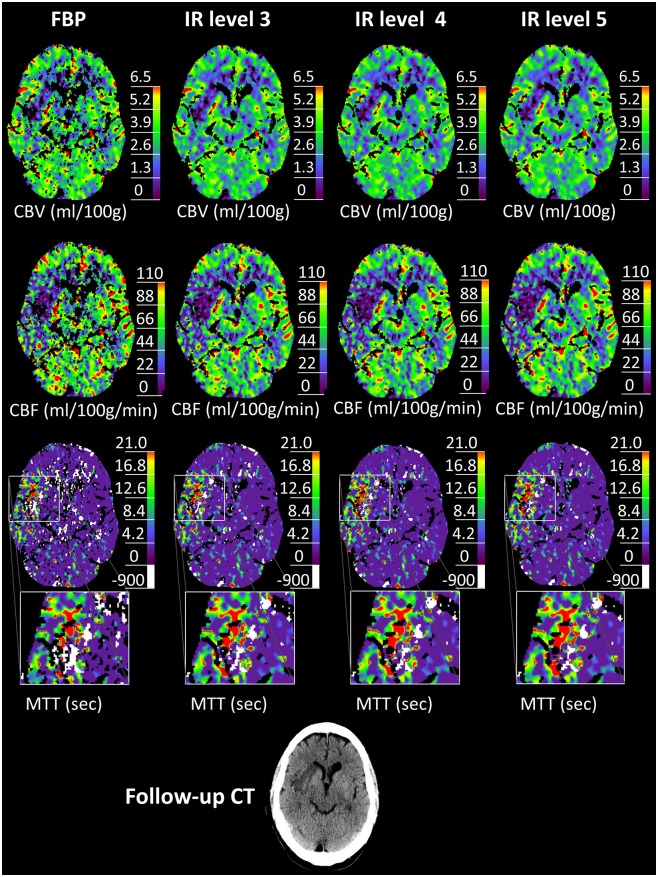
Example CTP images 1.Note the improved image quality from FBP to IR levels 3–5 (rated 1.3, 2.0, 3.6 and 3.0, respectively). With rising levels of IR, error voxels (i.e. voxels without perfusion information, white) diminished in favor of voxels with perfusion information (colored). For this patient, as for 19 out of 23 patients, the assessment of a relevant perfusion mismatch did not depend on the reconstruction algorithm.